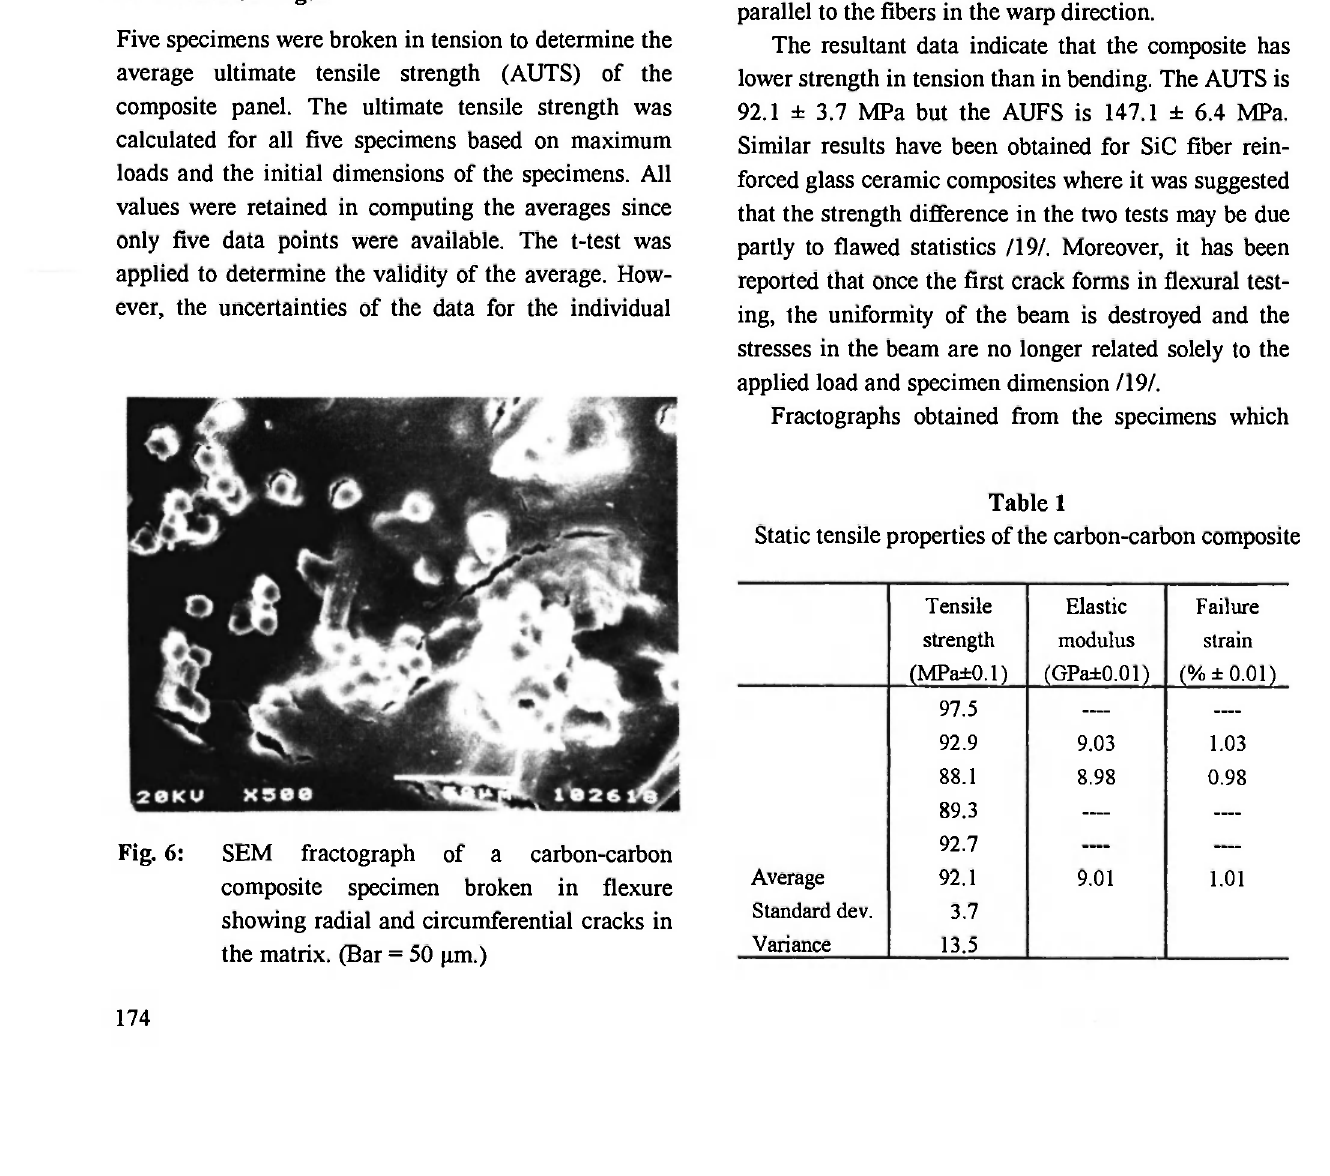
Fig. 6: SEM fractograph of a carbon-carbon composite specimen broken in flexure showing radial and circumferential cracks in the matrix. (Bar = 50